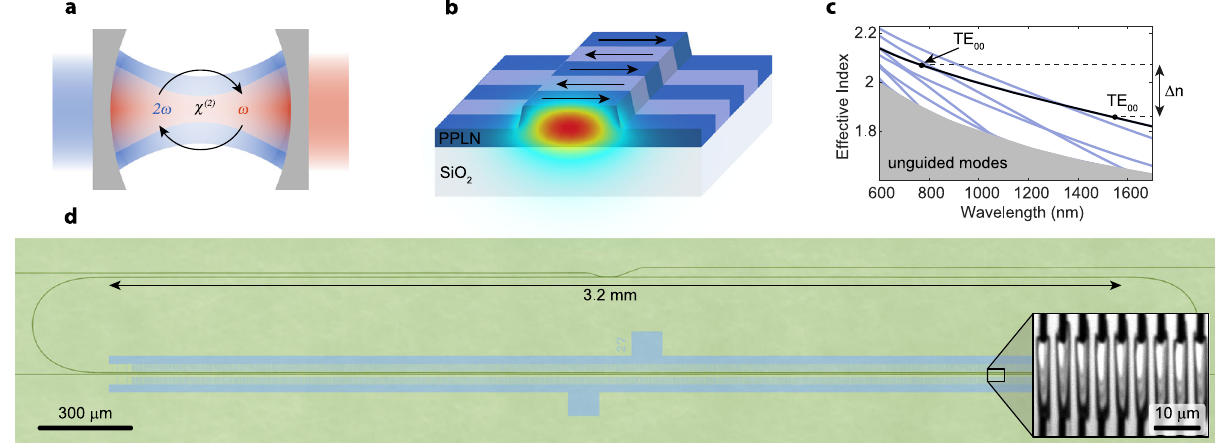
Fig. 1 Integrated, resonant second-order nonlinear optical device. a Schematic of a resonant second-order nonlinear optical device. Driving the cavity with second harmonic light (blue) results in optical parametric oscillation at the fundamental; Driving at the fundamental frequency generates second harmonic light. b Periodically-poled lithium niobate ridge waveguide that con fi nes light to a small volume and supports nonlinear interactions. The transverse electric fi eld parallel to the surface of the chip is plotted for the fundamental spatial mode. c Effective index of the waveguide spatial modes as a function of wavelength. Periodic poling compensates for the phase velocity mismatch ( ∝ Δ n ) between fundamental and SH modes. d The racetrack resonator used as a platform for nonlinear optics. Laser light is injected through an evanescent coupler on the top and undergoes nonlinear interaction in the bottom, periodically-poled section. The resonator is not coupled to the waveguide below it, which serves as a tool for poling diagnostics. The laser confocal microscope picture has been colorized; blue shading highlights the poling electrodes location during the fabrication process. Inset shows a second- harmonic microscope picture of the poled region. Inverted domains stretch between black electrode fi